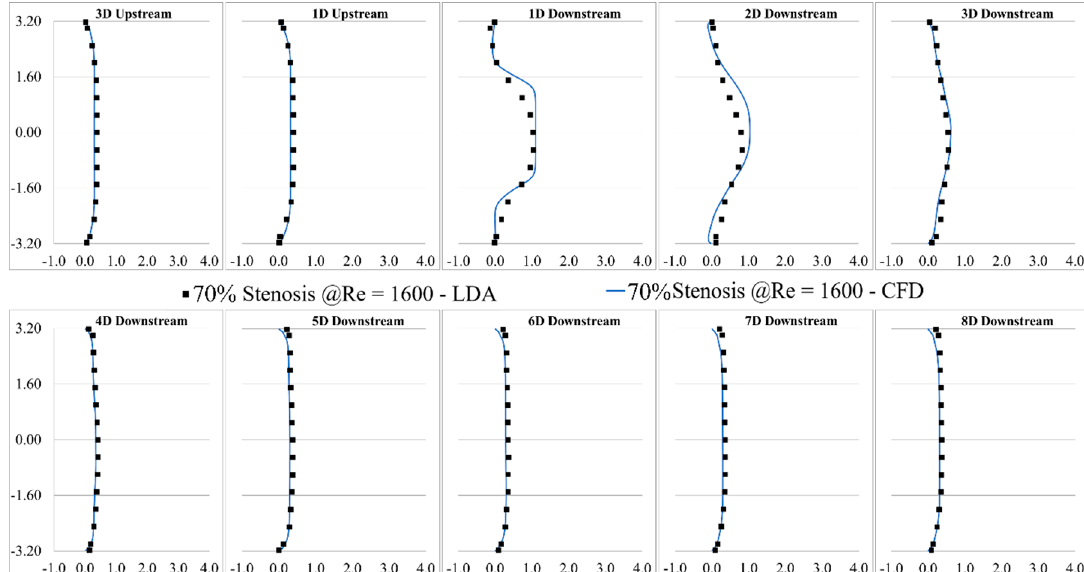
Figure 3. Validation of the computational results of 70% stenosis at Re = 1600 compared with the LDA measurements.